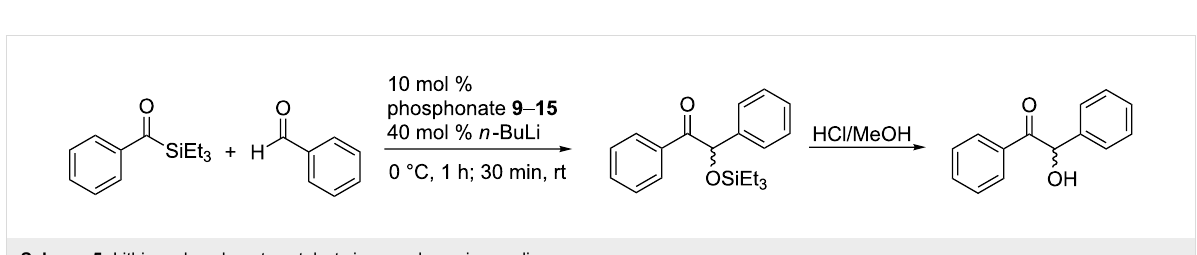
Scheme 5: Lithium phosphonate catalysts in cross benzoin